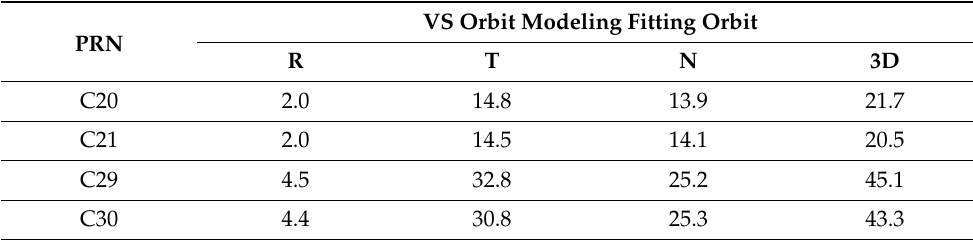
VS Orbit Modeling Fitting Orbit